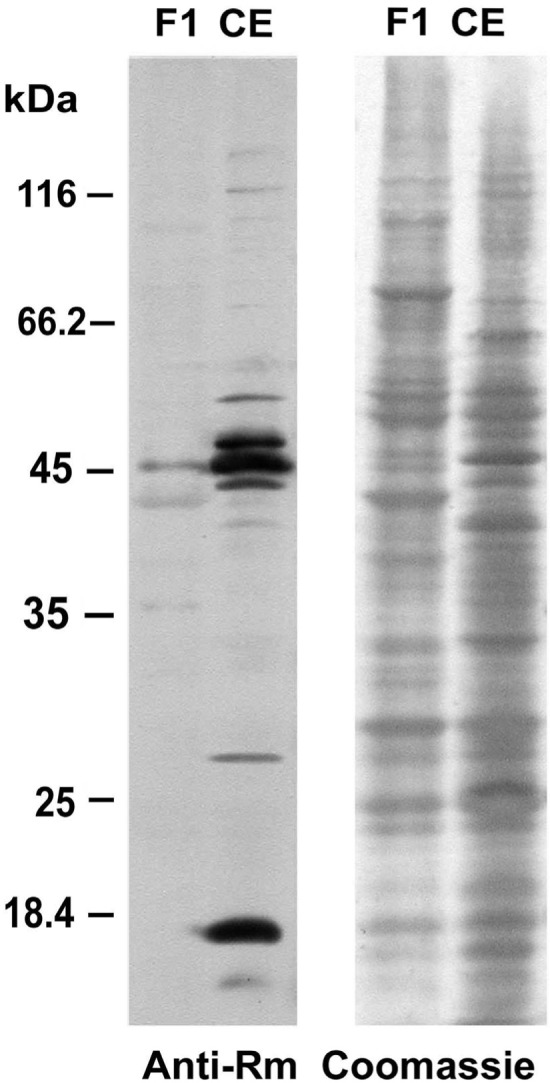
Western blot analysis of proteins from the eyespot fraction F1 and a CE with the anti-methyl-arginine specific antibody 7E6. Proteins (8 μg) were separated by 11% SDS-PAGE, transferred to a PVDF membrane, and either analyzed with a monoclonal anti-methyl-arginine antibody (Anti-Rm; 1:2,500) or stained with Coomassie Brilliant Blue R250 (Coomassie).